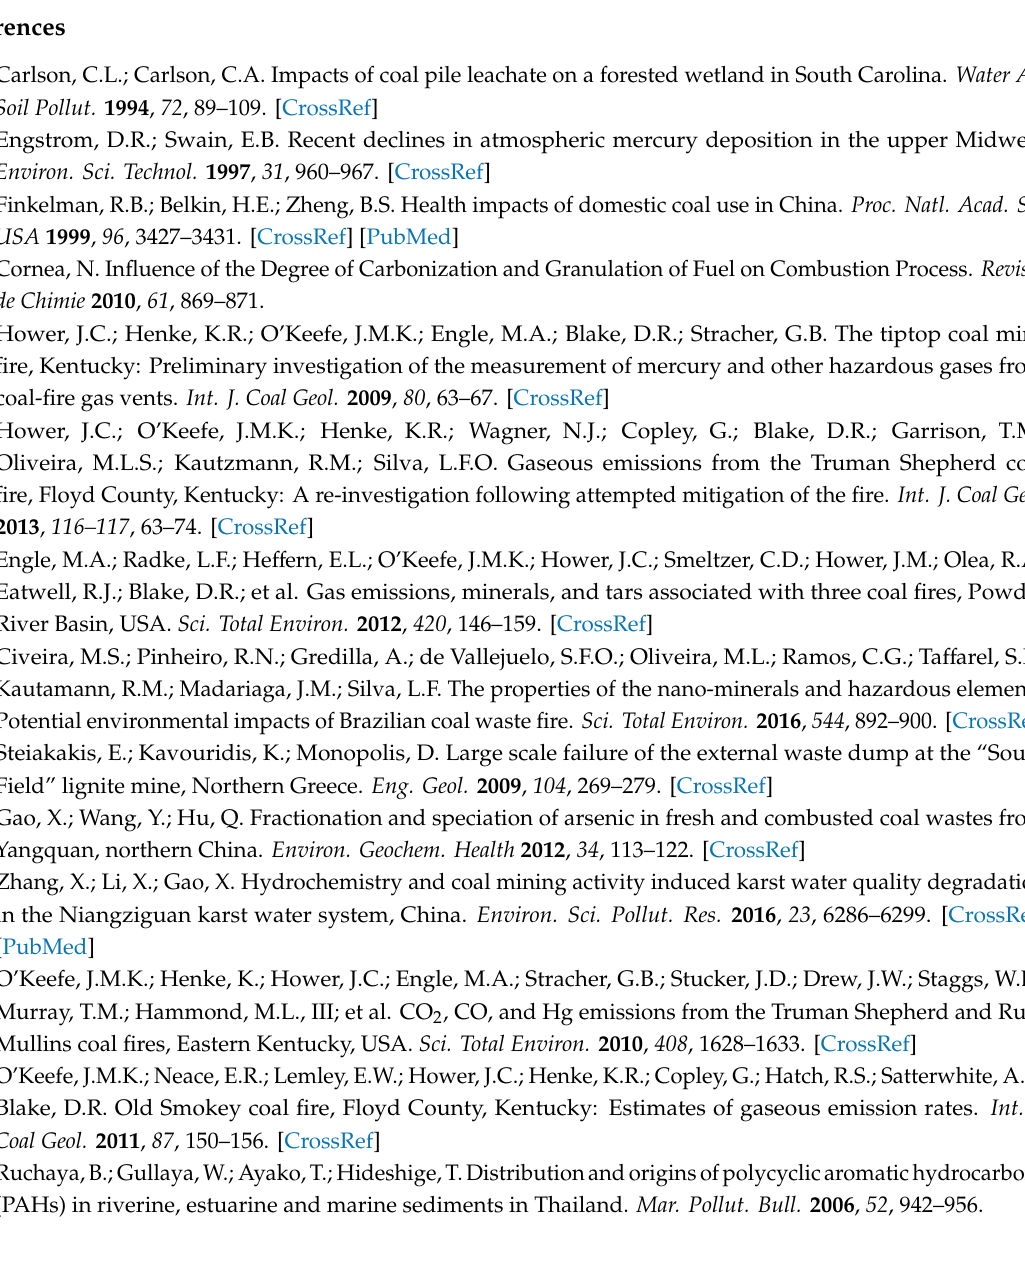
Figure S1: Location of major coal spoil piles in the study area; Figure S2: XRD patterns for coal gangue, fired coal gangue, and contaminated soil; Table S1: PAHs content release from coal spoil samples in heating / burning test under di ff erent temperatures (ng / g, dry